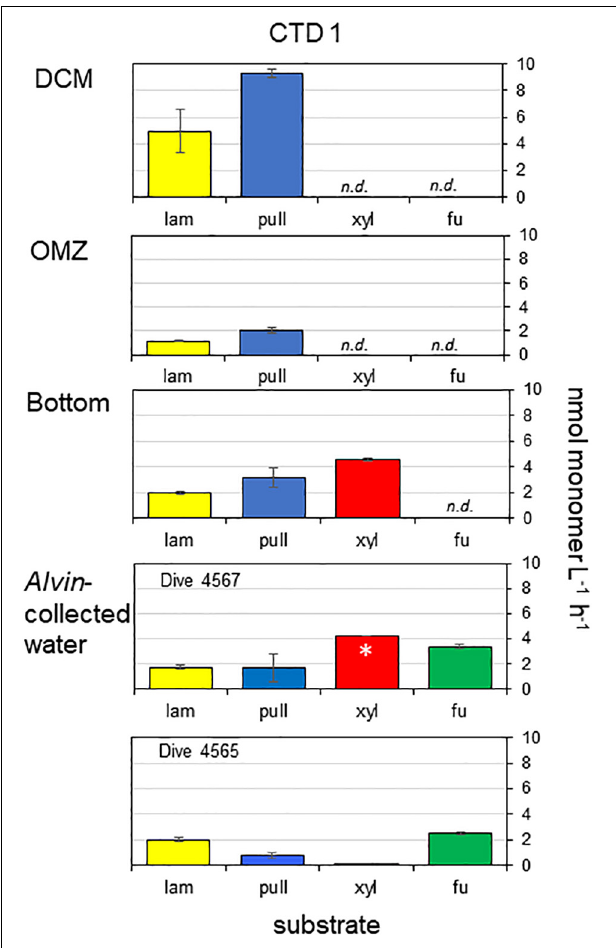
FIGURE 2 | Activities of endo-acting enzymes in water taken from CTD cast 1 and in water taken with HOV Alvin . Lam, laminarin; pull, pullulan; xyl, xylan; fu, fucoidan. Hydrolysis rates are average rates of n = 2 ± their range. n.d. means not detectable. ∗ means that hydrolysis was detected in only one of the